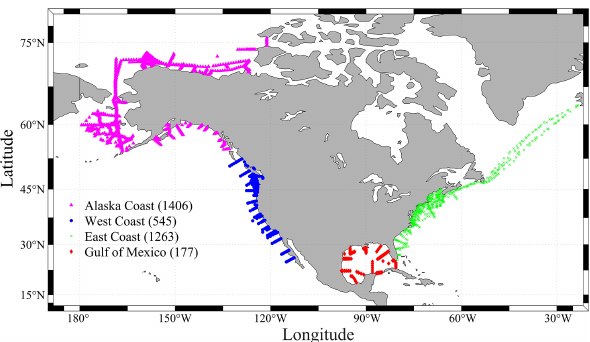
Figure 1. A map showing all the sampling locations of the CODAP- NA data product (v2021, a total of 3391 profiles). Magenta triangles show the sampling profiles at the Alaska coast (AC). Blue ones are for the west coast (WC), green crosses are for the east coast (EC), and the red diamonds are for the Gulf of Mexico (GMx). Numbers within the parentheses indicate the total number of profiles in the